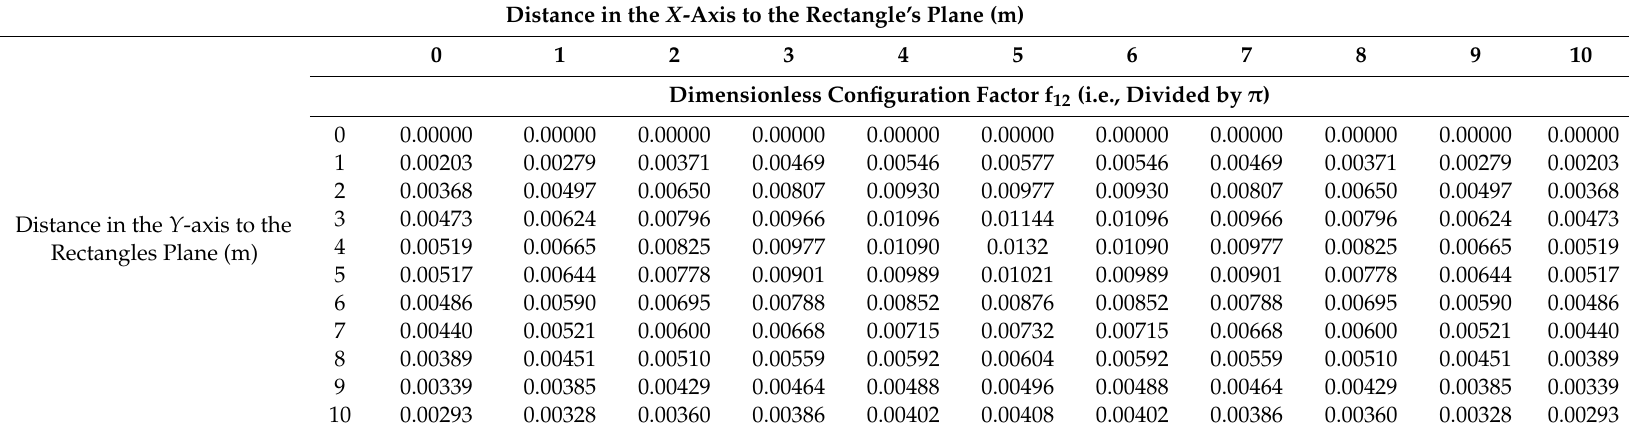
Table 1. Configuration factors of an area of 10 × 10 m 2 illuminated by a ‘rectangle’ of 2 × 2 m 2 located 5 m from the ground at the middle point of the horizontal surface.